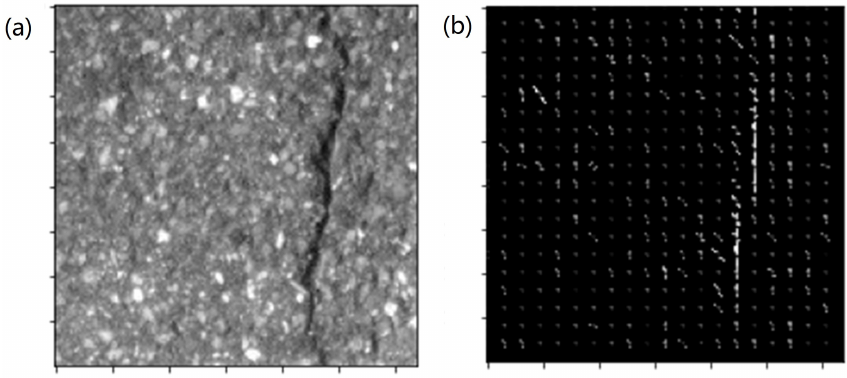
Figure 4. ( a ) Raw image and ( b ) its Fgg feature